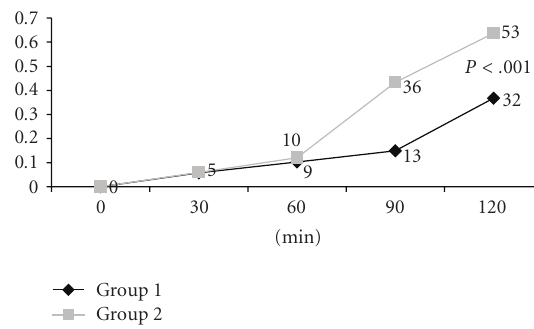
Figure 2: Patient number with ST-segment resolution in the course of